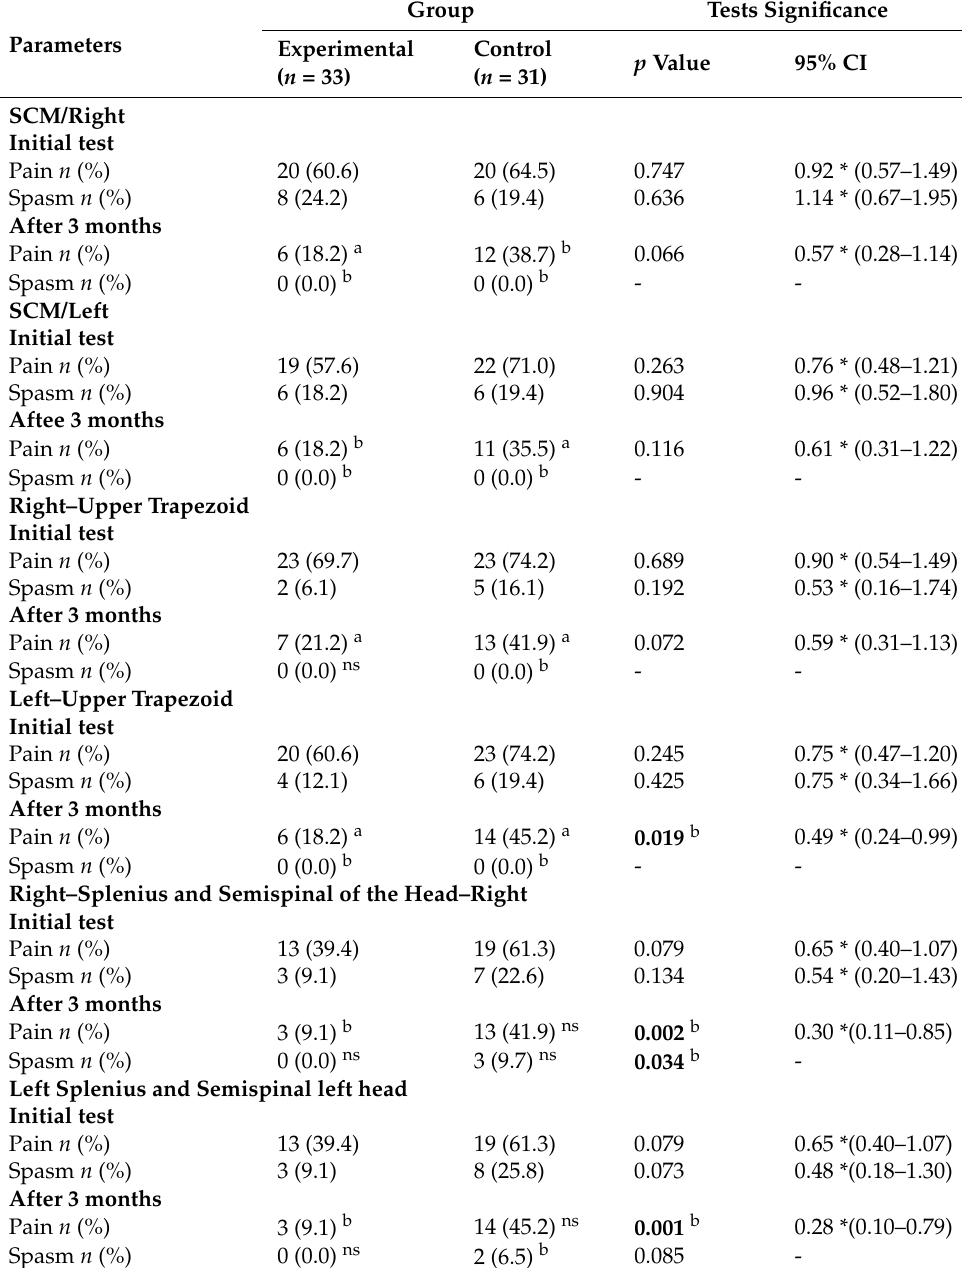
Table 3. Cervical spine muscle